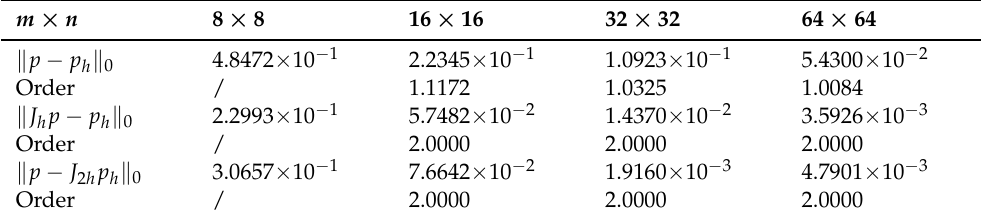
Table 6. The numerical errors and convergence orders at t = 1.0 of p